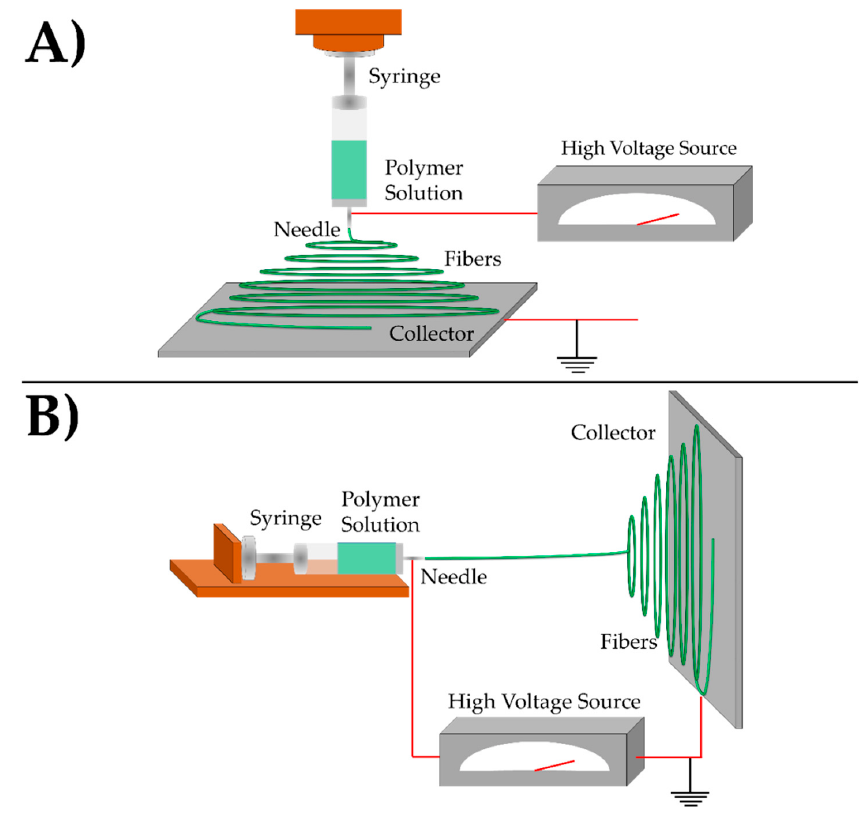
Figure 2. Schematic showing the set-up of a ( A ) vertical electrospinning system and ( B ) horizontal electrospinning system.